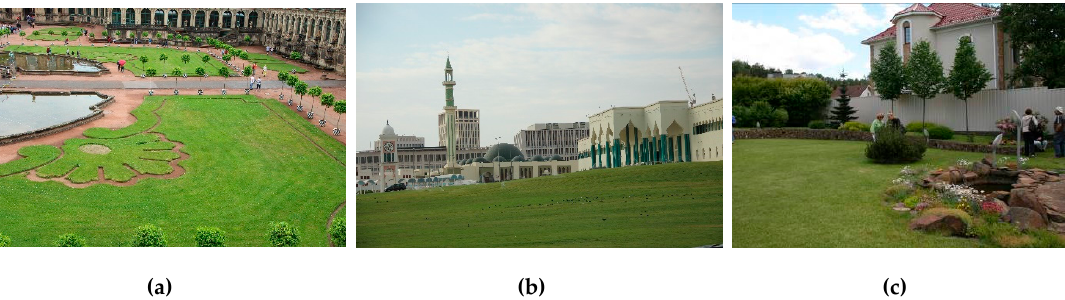
Figure 5. Lawns as symbols of beauty, power and prosperity: ( a ) Lawns are a dominant feature of decorative parterre in the formal (French style) garden of Zwinger Palace, Dresden, Germany; ( b ) Lawn in front of a mosque in Doha, Qatar; ( c ) Manicured lawn in a private villa, suburb of Moscow, Russia. Photos: M. Ignatieva.